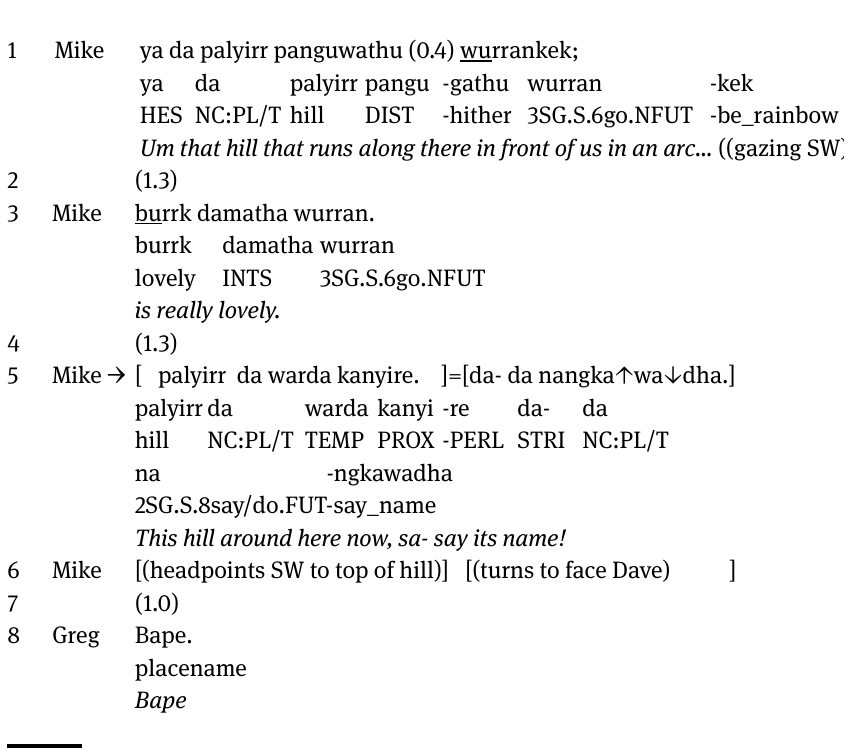
Figure 5: Seated on the arc-shaped hill Thuykem , Mike (on the right) is more or less facing the nearby hill Bape . (3) Thuykem